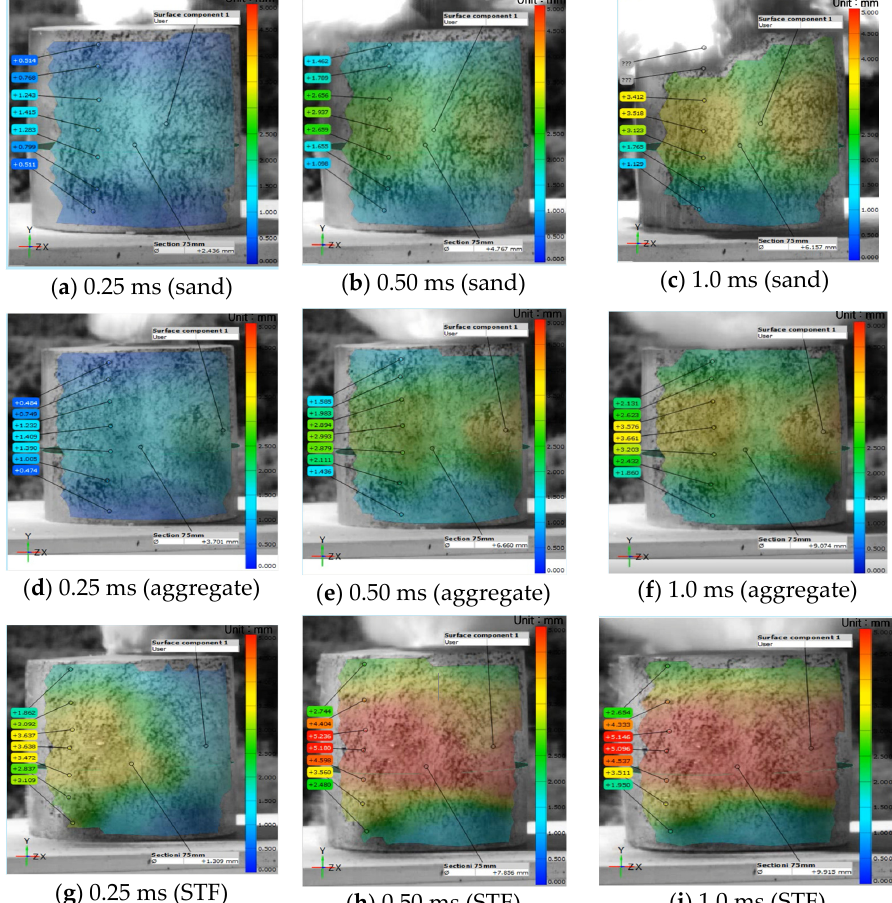
Figure 11. Surface displacement of the lead block after detonating.